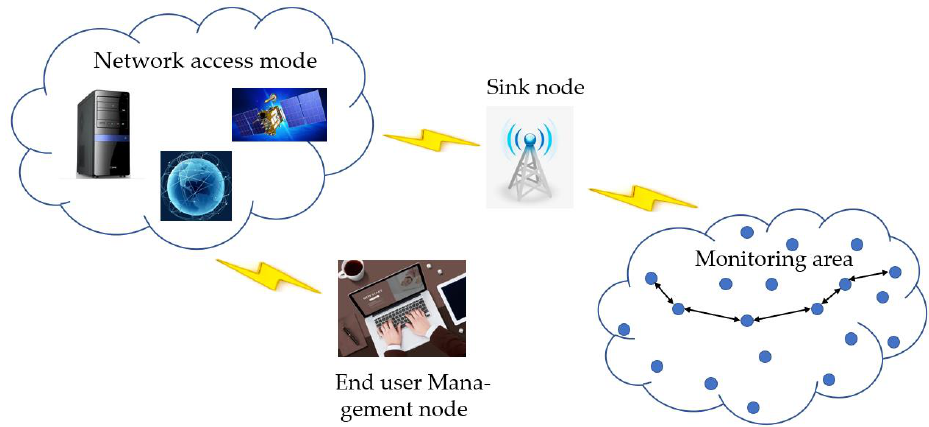
Figure 2. The architecture of a wireless sensor network based on the Internet of Things.